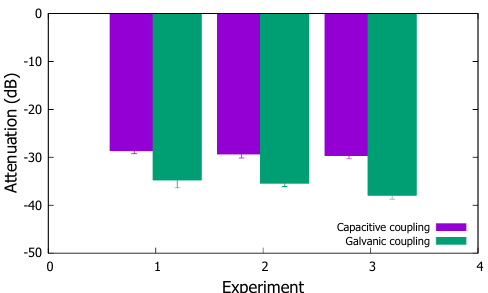
Figure 4. EM Wave attenuation for capacitive and gavanic coupling with different electrode